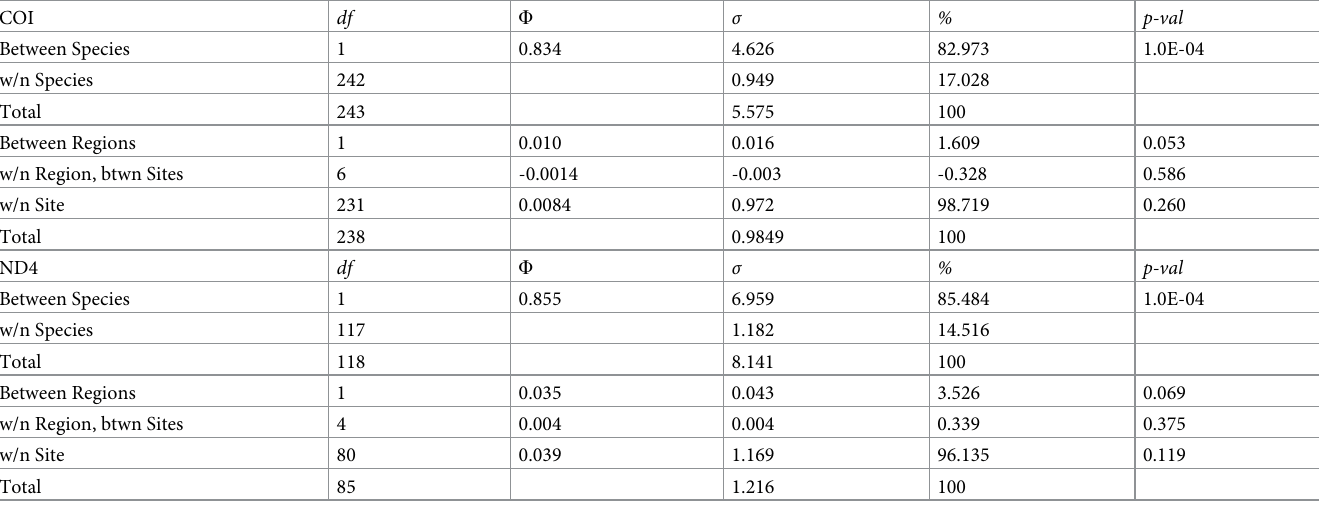
Table 3. Analysis of Molecular Variation (AMOVA) between Bathymodiolus childressi and B . mauritanicus species and within and between regions for B . childressi . COI